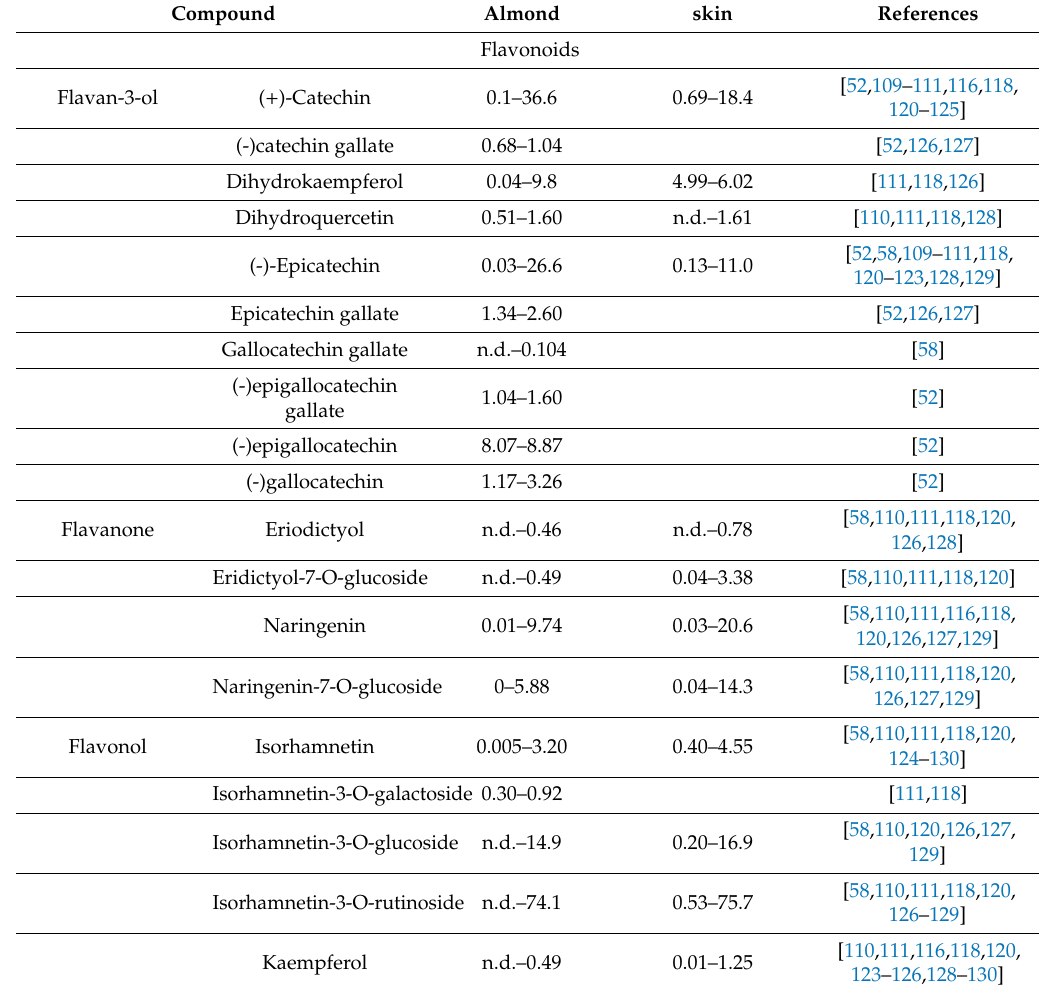
Table 6. Phenolic compounds quantified in almonds and almond skins (mg / 100